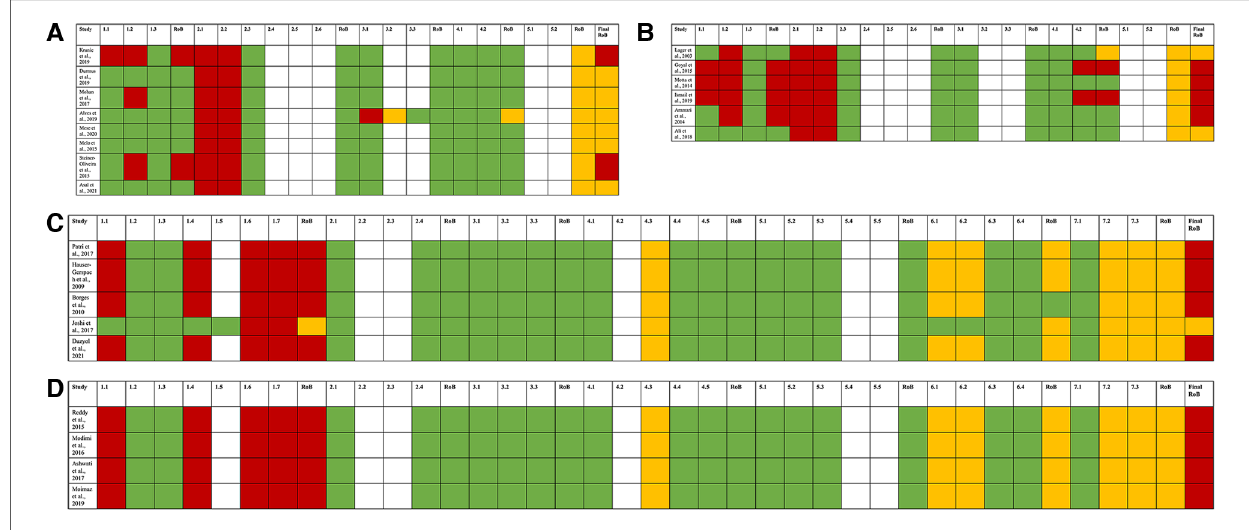
FIGURE 2 Risk of bias of 7 randomized controlled trials (RCTs) of antiseptic agents assessed through RoB 2.0 ( A ); risk of bias of 7 randomized controlled trials (RCTs) of chemomechanical methods assessed through RoB 2.0 ( B ); risk of bias of 5 non-randomized controlled trials (NRCTs) of antiseptic agents assessed through ROBINS-I ( C ); risk of bias of 4 non-randomized controlled trials (NRCTs) of chemomechanical methods assessed through ROBINS-I ( D ). For RoB 2.0, high risk of bias is represented in red; some concerns are represented in yellow; low risk of bias is represented in green. For ROBINS-I, serious risk of bias is represented in red; moderate is represented in yellow; low risk of bias is represented in green. There was not any study classi fi ed as critical risk of